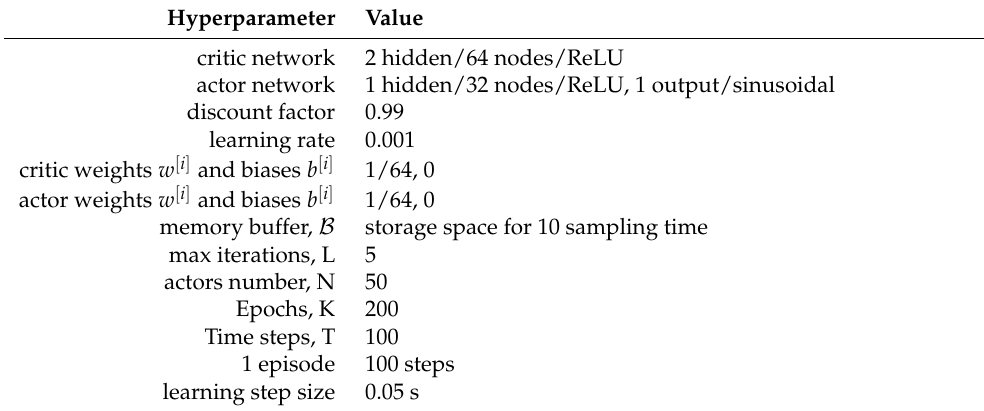
Table 2. Hyperparameters used in